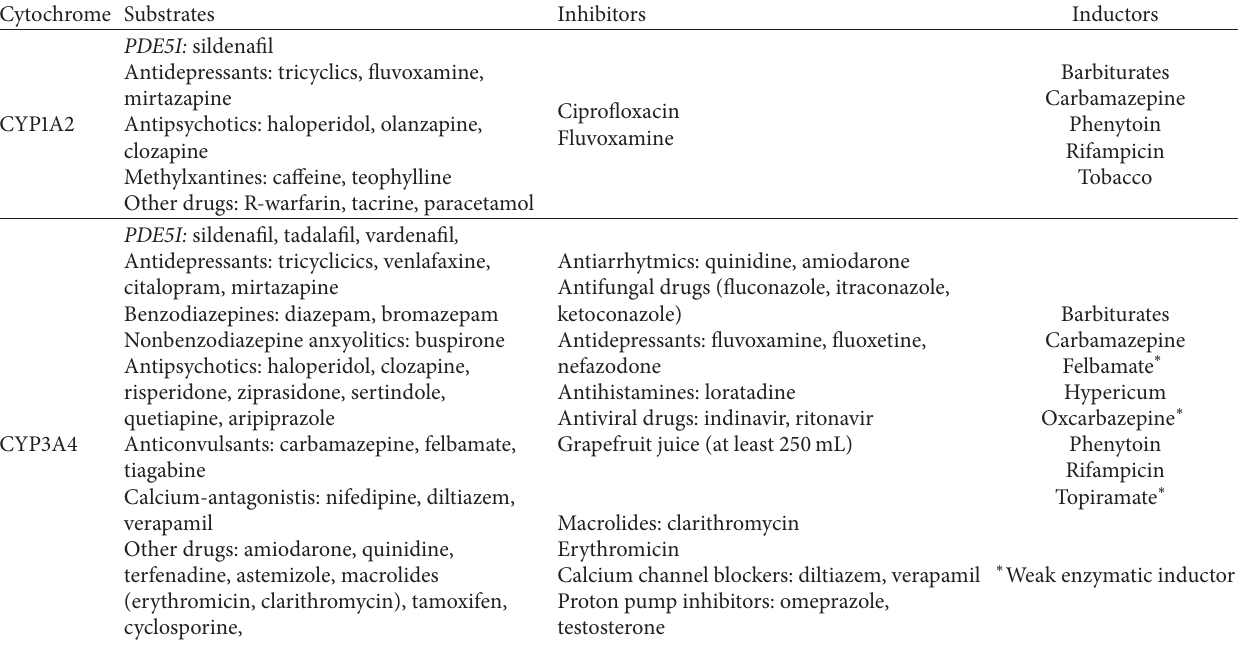
Table 1: Some examples on potential interactions among PDE5I and other drugs via